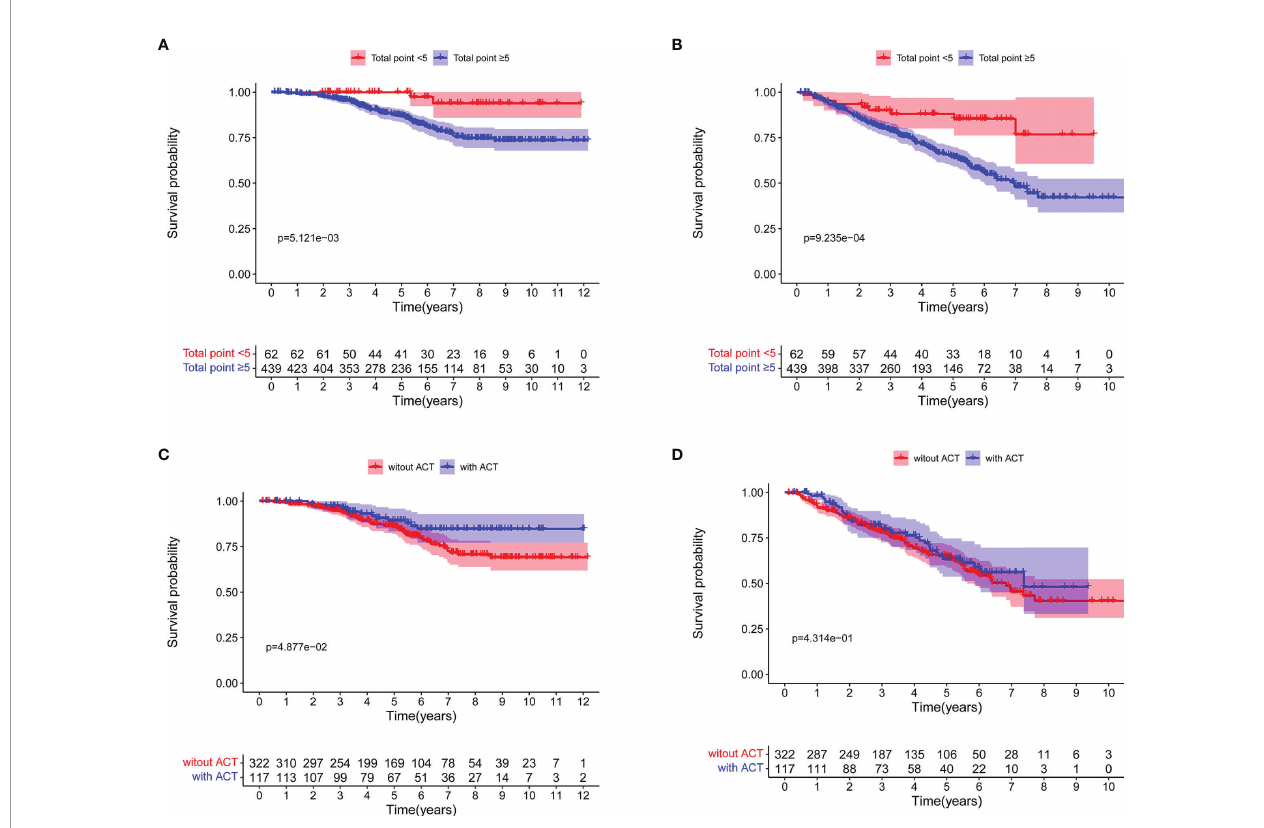
FIGURE 4 | Survival curves for patients with total points <5 and total points ≥ 5 based on the nomogram for overall survival (OS). (A) OS; (B) Disease-free survival (DFS). Survival curves for patients with total points ≥ 5 based on the nomogram for OS. (C) OS; (D) DFS.